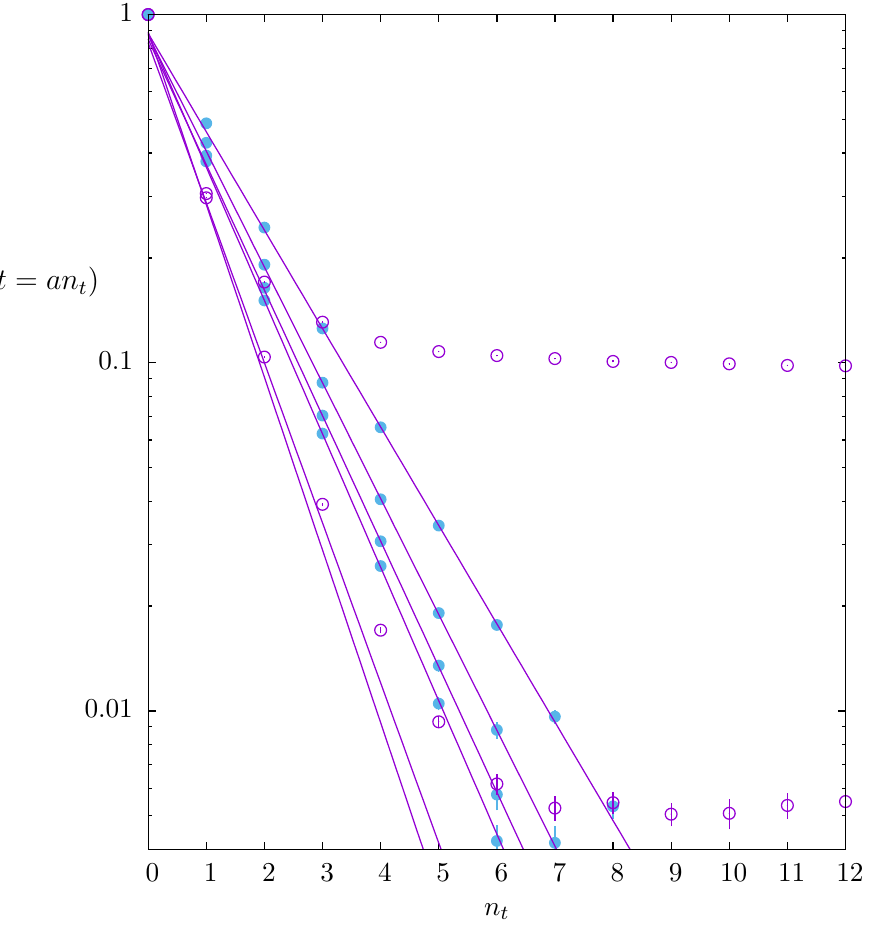
Figure 17 . Correlation functions of the ground and (cid:12)rst 3 excited (cid:13)ux tube states ( (cid:15) ) and also the 8’th and 10’th excited states ( (cid:14) ). Exponential (cid:12)ts also shown, as described in text. In SO(3) at (cid:12) =